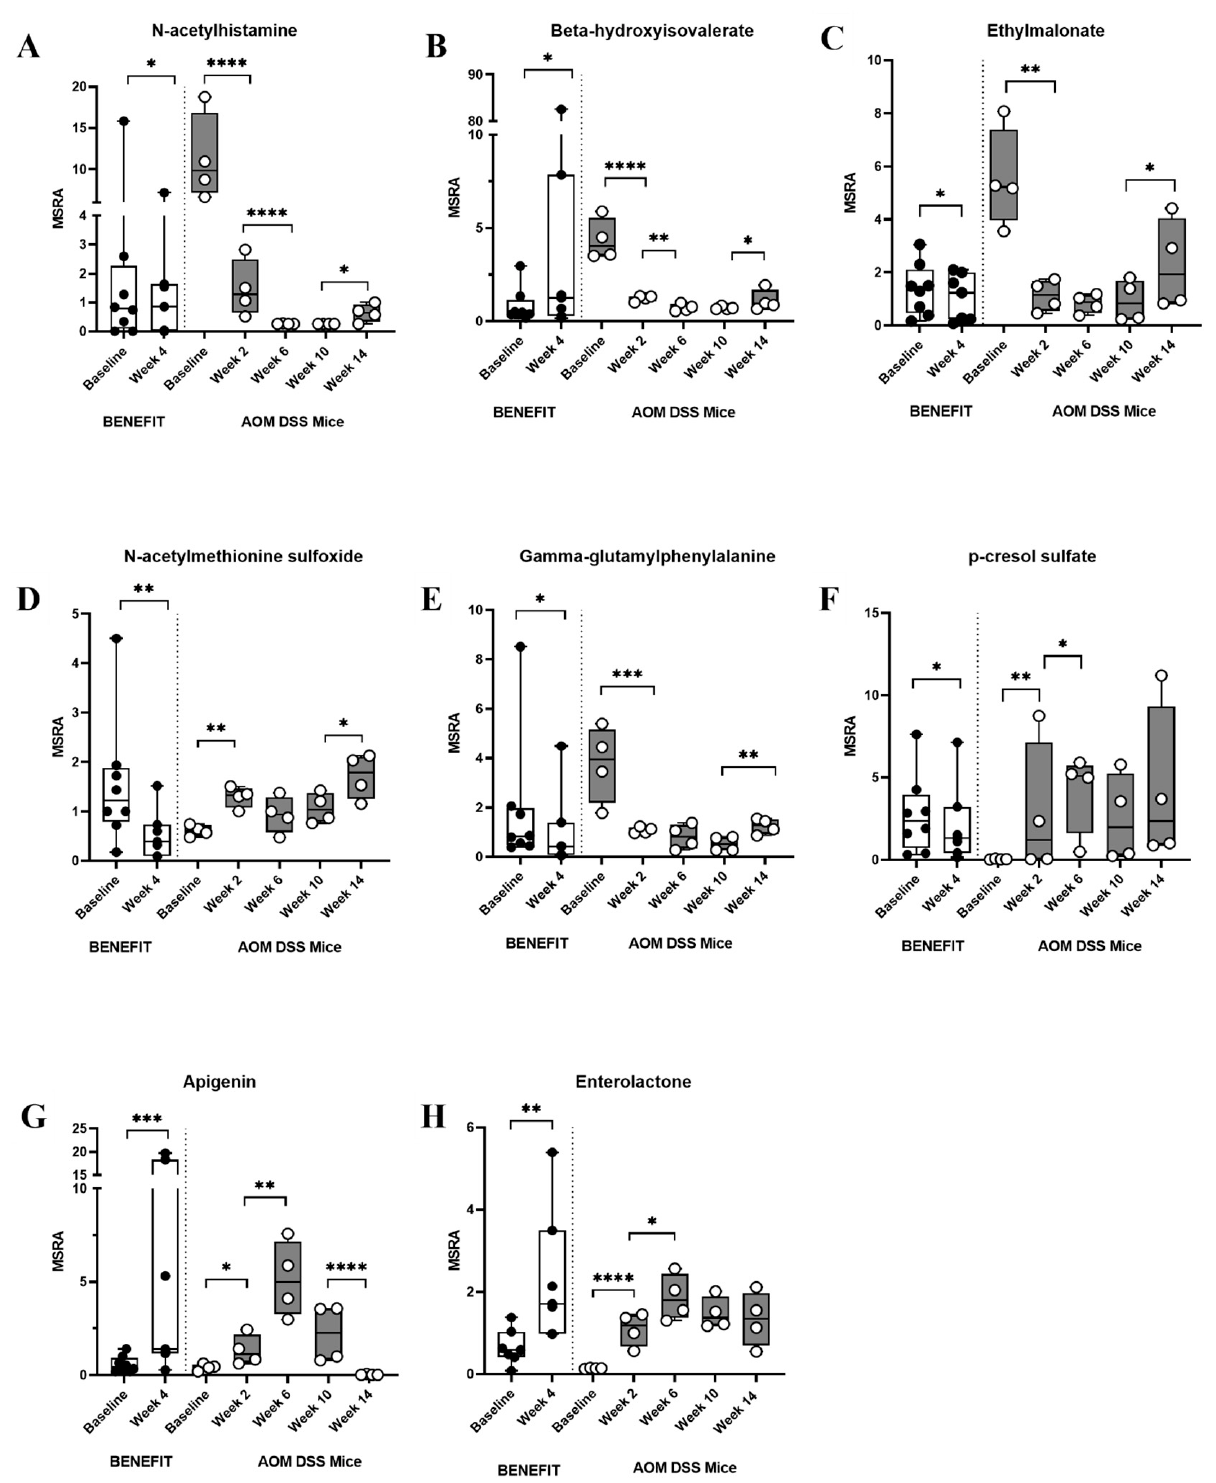
Figure 4. Median-scaled relative abundances (MSRA) for human fecal metabolites from the Beans/Bran Enriching Nutritional Eating For Intestinal Health Trial (BENEFIT) study at 4 weeks compared to baseline are depicted ( left ). MSRAs for murine fecal metabolites from the rice bran group at baseline, and 2, 6, 10, and 14 weeks ( right ). ( A ) N-acetylhistamine, ( B ) beta-hydroxyisovalerate, ( C ) ethylmalonate, ( D ) N-acetylmethionine sulfoxide, ( E ) gamma-glutamylphenylalanine, ( F ) p-cresol sulfate, ( G ) apigenin, and ( H ) enterolactone (* = p < 0.05, ** = p < 0.01, *** = p < 0.001 and **** = p <